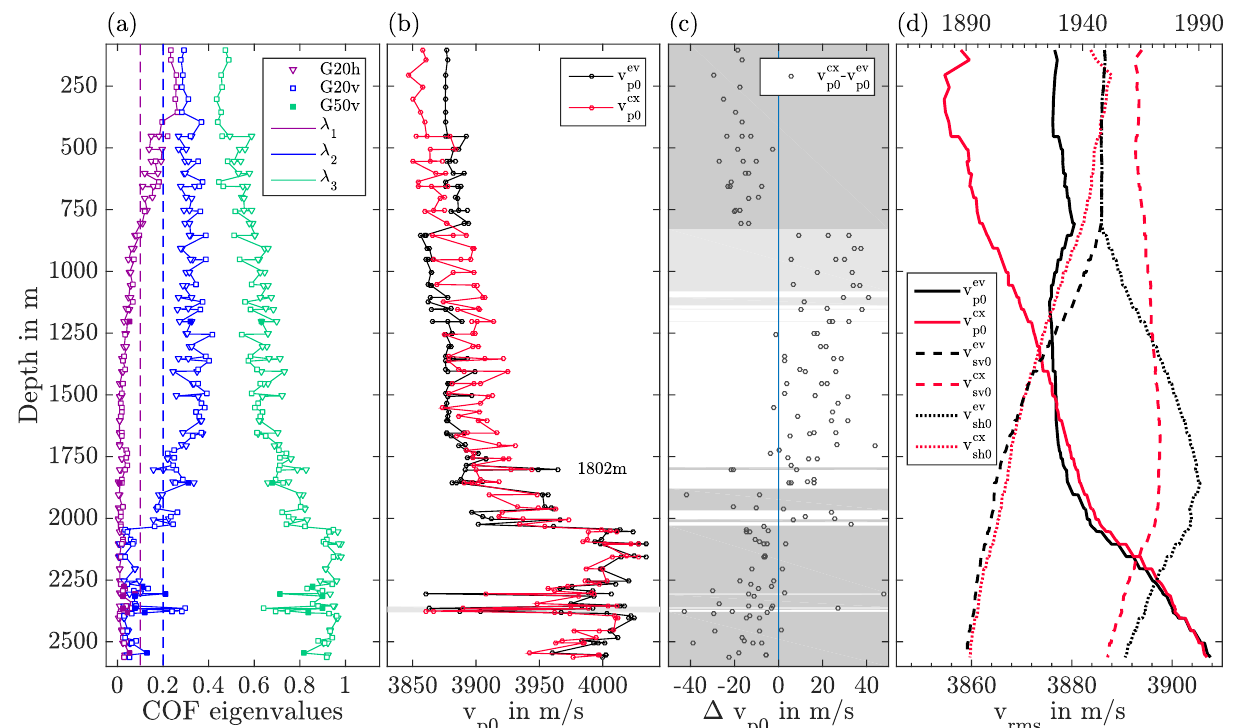
Figure 4. Comparison of zero-offset velocities calculated from EDML fabric data (without high-resolution samples) via ev and cx frame- work. (a) Eigenvalues (symbols and solid lines for visual assistance) and threshold values (dashed lines, ev framework) for girdle fabric classification. The different symbols used for eigenvalue data indicate horizontal (h, triangle) and vertical (v, square) thin sections, and the used fabric analyser model. Panel (b) presents the calculated interval P-wave velocities for the two frameworks. The shaded interval around 2270m indicates where high-resolution measurements were taken (Fig. 5). Panel (c) relates the difference (cid:49)v p0 = v cx classes that are indicated by shading (dark grey: cone, light grey: thick girdle, white: partial girdle). For each data point the shading extends to half the distance to the neighbouring data points. Panel (d) shows the seismic rms velocities resulting from the interval velocities integrated from the surface (without taking density, temperature and firn into account); S-wave velocities refer to the upper x axis and P-wave velocities to the lower x